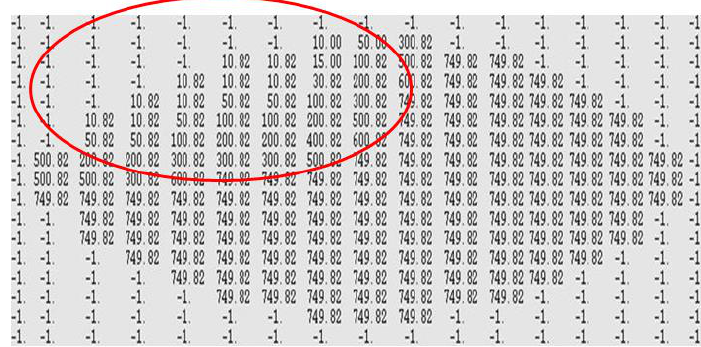
Figure 2 : Inhomogeneous Dilution - Core Radial Plane